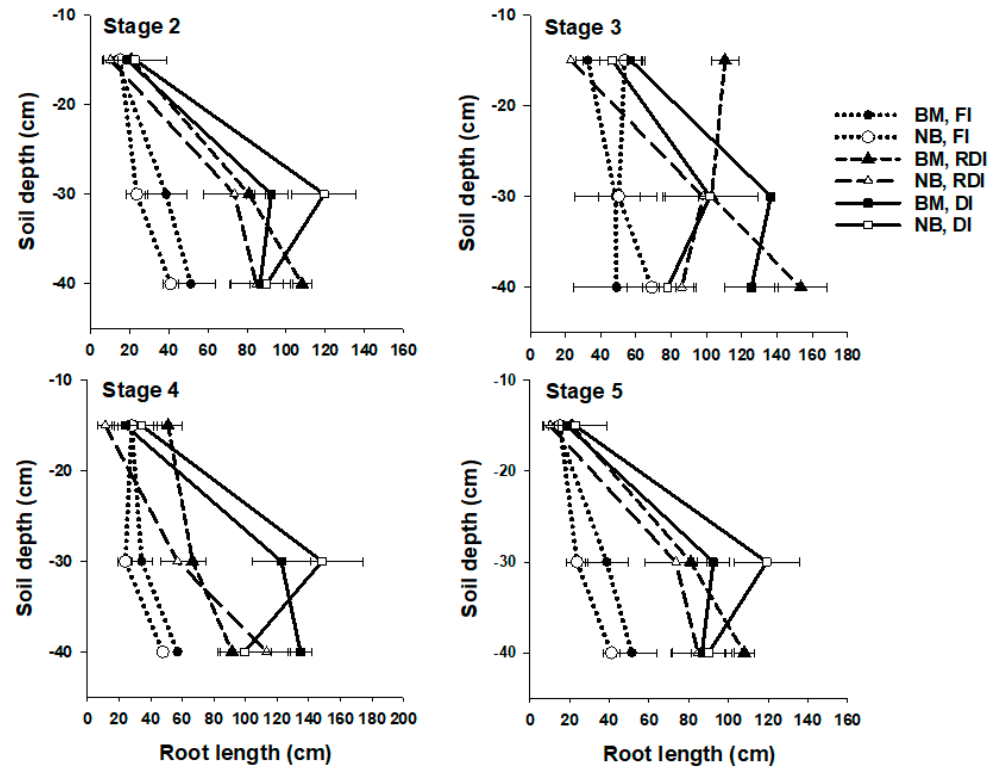
Figure 6. Effects of irrigation and N application timing on tomato root length during spring 2018 season in Immokalee, Florida. (BM = 25% pre-plant with 75% fertigation, NB = zero pre-plant with 100% fertigation. FI = full irrigation at 100% ETc, DI = deficit irrigation at 66% ETc and RDI = regulated deficit irrigation at 66% ETc, 0-4 weeks after transplanting and 100% ETc from week 5). Error bars = 1 standard error.